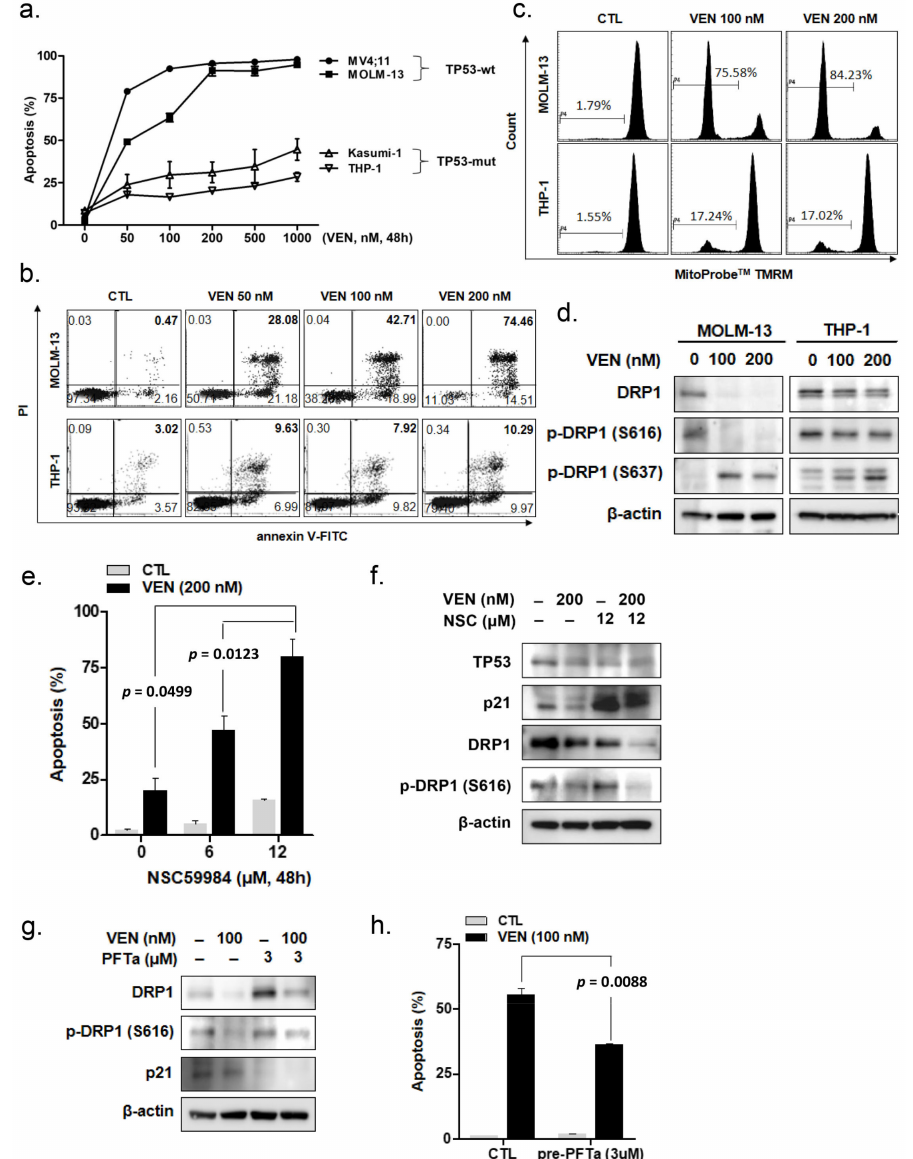
Figure 1. Effects of venetoclax in TP53-wild-type (TP53wt) and TP53-mutant (TP53mut) leukemia cells. ( a , b ) TP53wt leukemia cell lines (MV4-11 and MOLM-13) and TP53mut leukemia cell